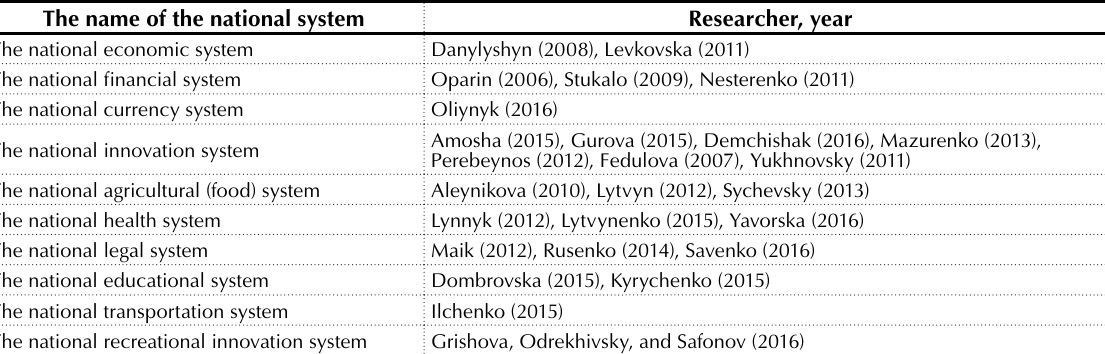
Source: developed by the